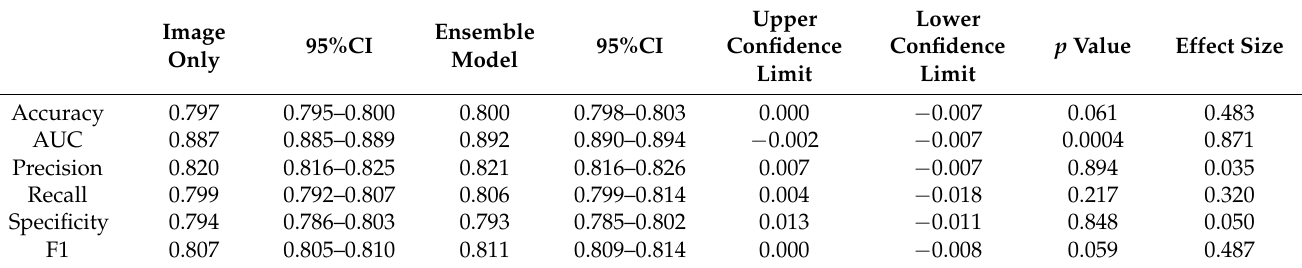
Table 5. Image-only model and ensemble model of each performance metric in